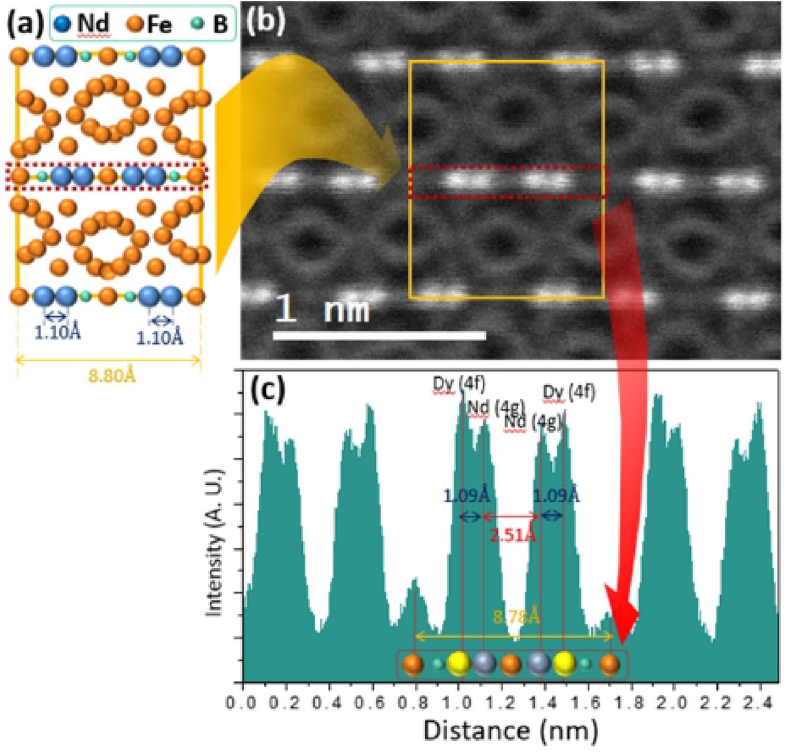
Figure 4. ( a ) Standard Nd 2 Fe 14 B unit cell with [100] zone axis ( b ) HADDF-STEM image of Nd 1.5 Dy 0.5 Fe 14 B at [100] zone axis, ( c ) intensity histogram for the atoms in the red dotted panel in ( b